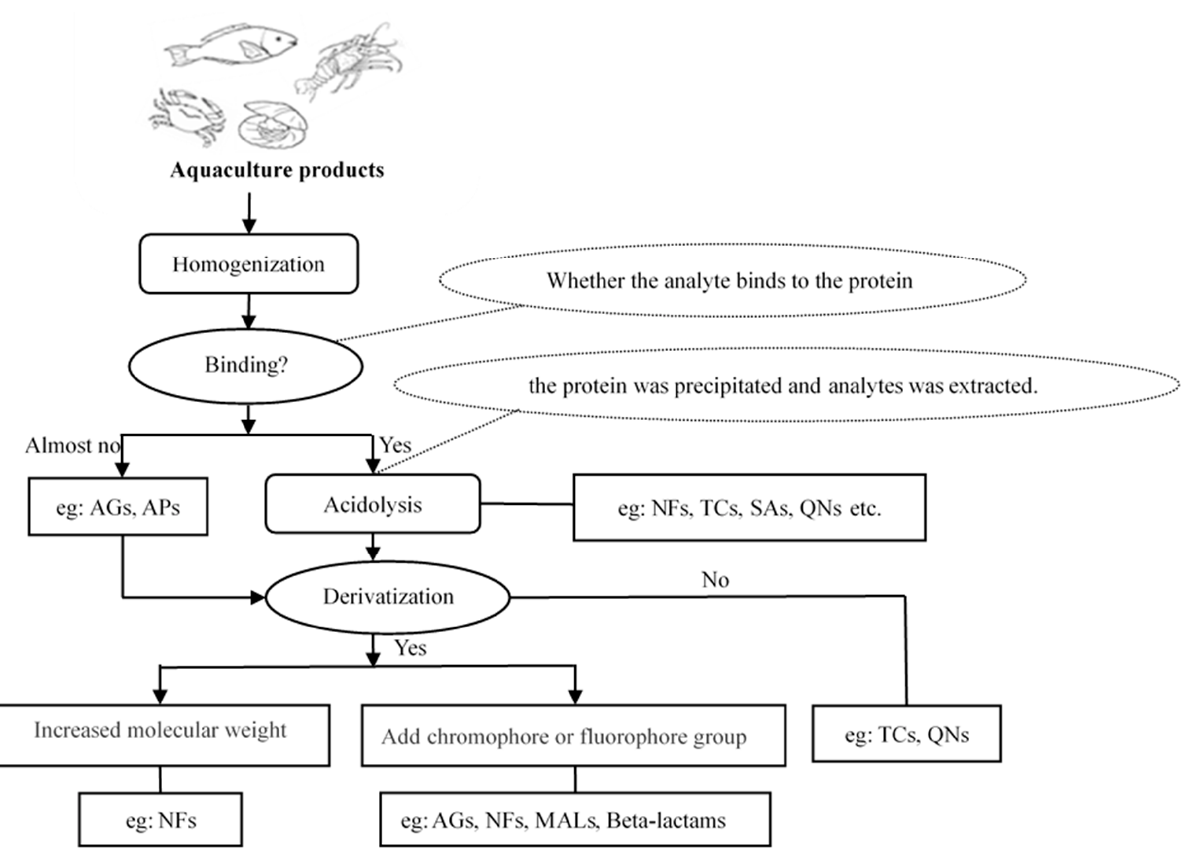
Figure 2. The current workflow of preliminary treatment for major antibiotics.